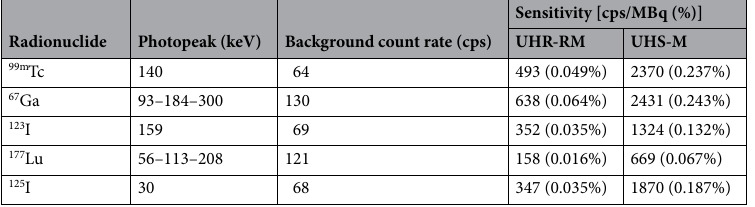
Table 2. Sensitivity values obtained for punctual sources of different radionuclides using UHR-RM and UHS-M collimators.